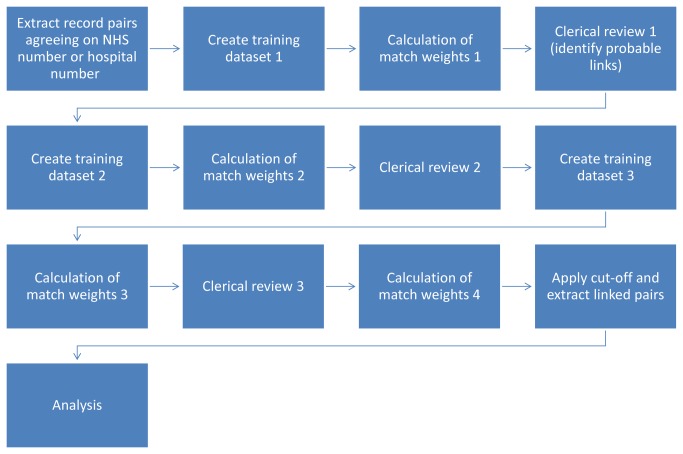
Match weight calculation process.